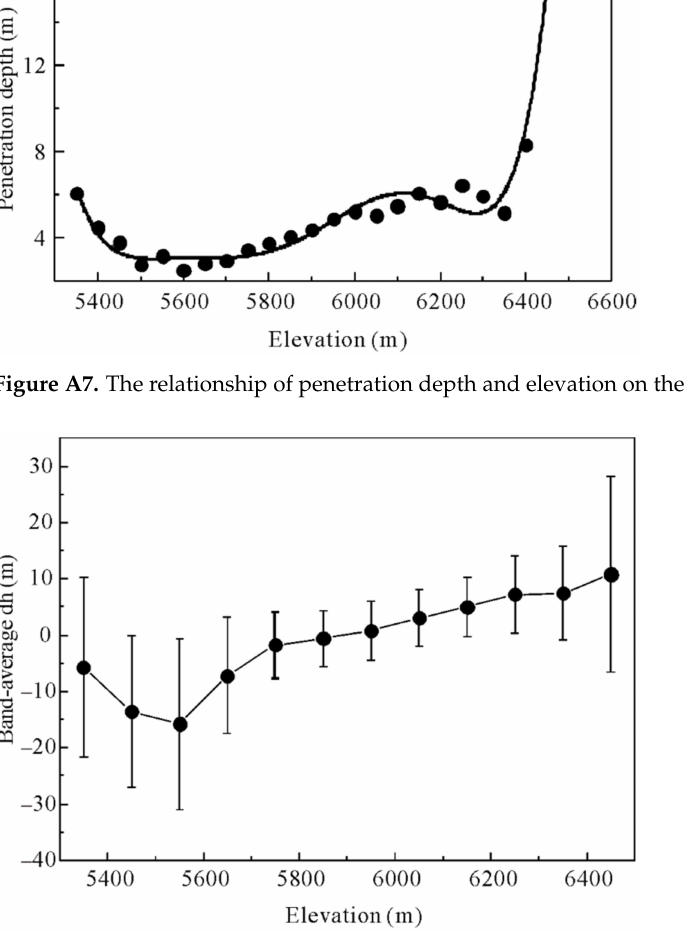
Figure A8. The 100-m band-average elevation difference between HMA and SRTM. The error bar represents one standard deviation.